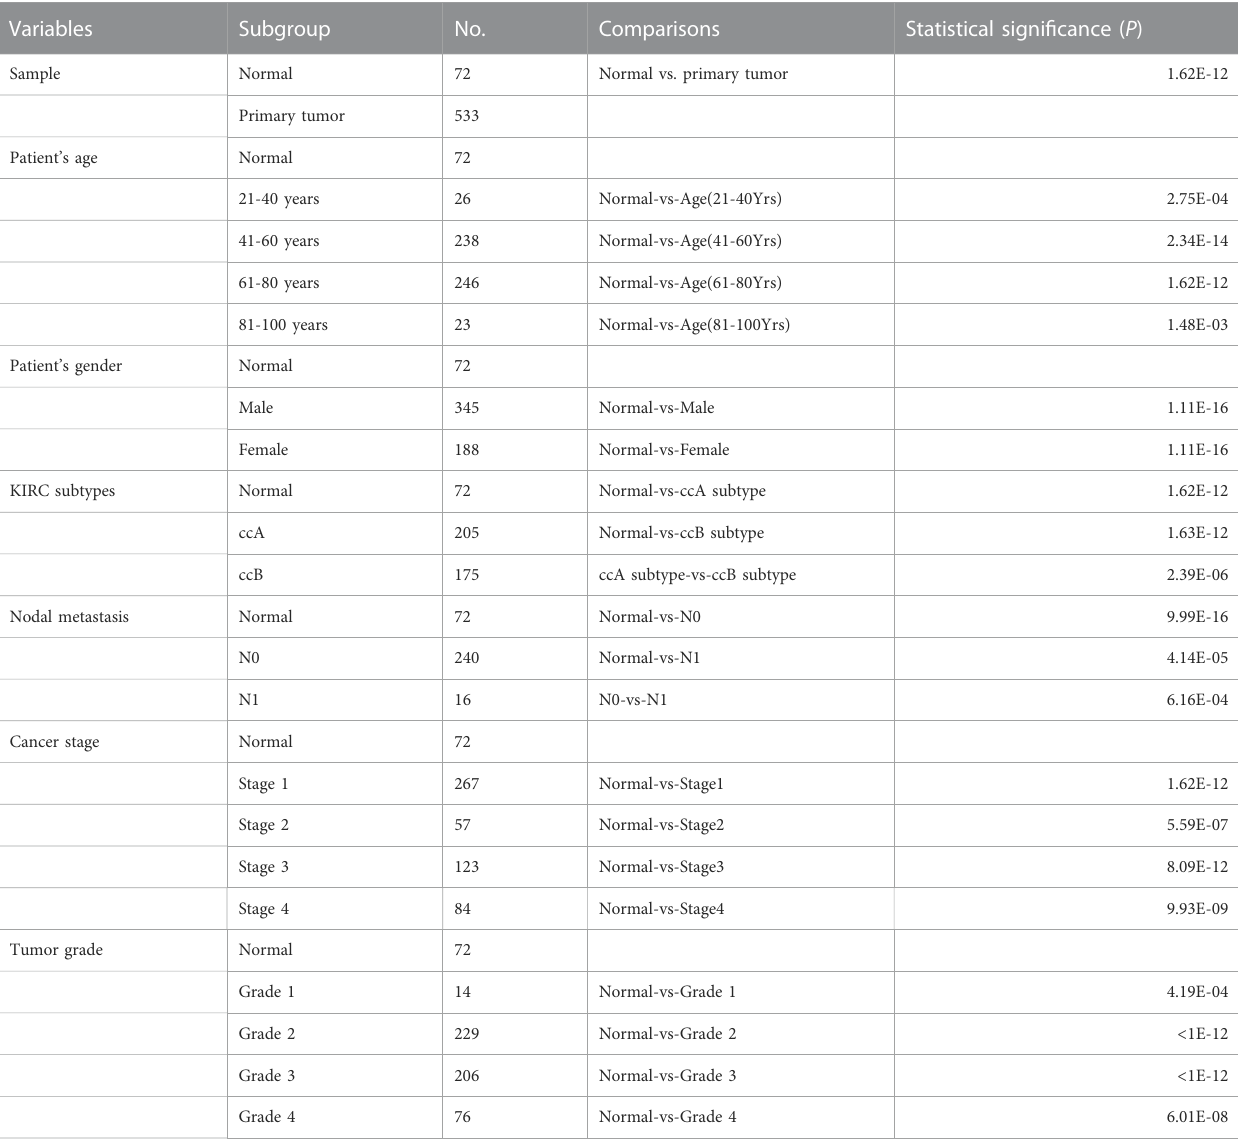
TABLE 1 The correlation between GTSE1 expression and different clinical